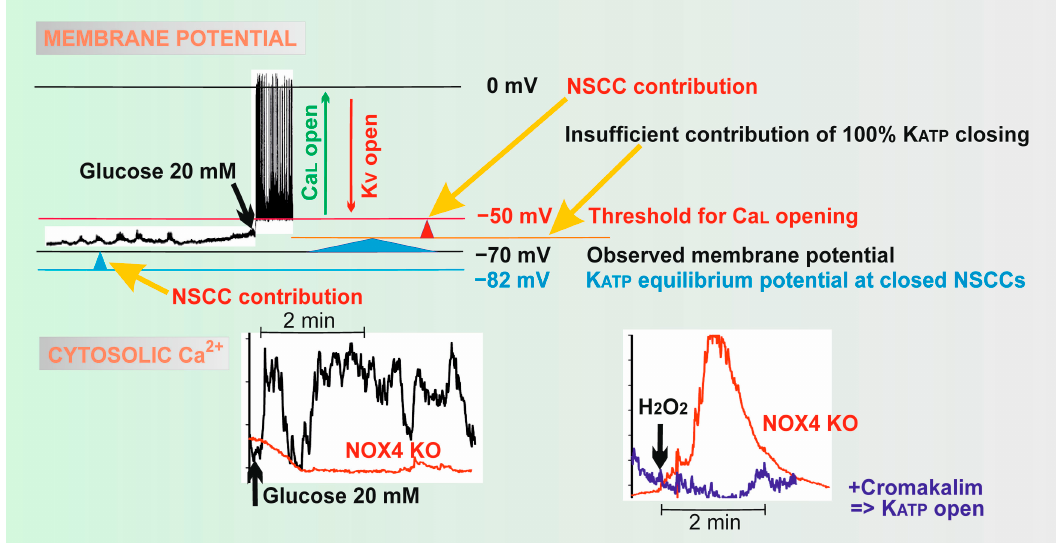
Figure 3. Schematics of parallel plasma membrane potential action potential vs. Ca 2+ oscillations in pancreatic β -cells after the addition of 20 mM glucose. Data similar to that published in Ref. [4] are used to illustrate: plasma membrane action potential firing (top) and Ca 2+ oscillations indicated with FURA2 in INS-1E cells silenced for NOX4 (red trace “NOX4 KO”) as compared with the Ca 2+ oscillations rescued in silenced cells by H 2 O 2 addition (bottom). The latter were prevented by cromakalim, keeping K ATP open. The observed resting plasma membrane potential accounts for − 70 mV in contrast to the theoretical potential of − 82 mV at equilibrium (blue line), if K ATP was contributing exclusively. The shift is caused at least by the non-specific Ca 2+ channels (NSCCs), the fluxes of which enable depolarization up to − 50 mV (red line), above which the activation of Ca V channels proceeds. The intermittent Ca V channel (and Na + channel) opening followed by the K V action creates the action potential spikes. Without the contribution of NSCCs, the 100% closed ensemble of K ATP channels would only reach a depolarization (orange line) that is insufficient for the activation of Ca V . Since Ca 2+ oscillations cease when H 2 O 2 was not supplied by NOX4 (red trace), one can explain the essential requirement of redox signaling by the two possible above-mentioned hypotheses that differ in the two distinct targets of H 2 O 2 : ( A ) either that K ATP is closed exclusively when both ATP plus H 2 O 2 are elevated (and TRPM2 can be independently also activated by H 2 O 2 ); or ( B ) that K ATP is closed by ATP, whereas the TRPM2 channel (or other NSCCs) is activated by H 2 O 2 . In both cases, the depolarization shift by NSCCs is essentially required for achieving the − 50 mV threshold for Ca V activation, despite 100% of the K ATP ensemble being closed. Patch-clamp results tend to support model ( A ) [4].